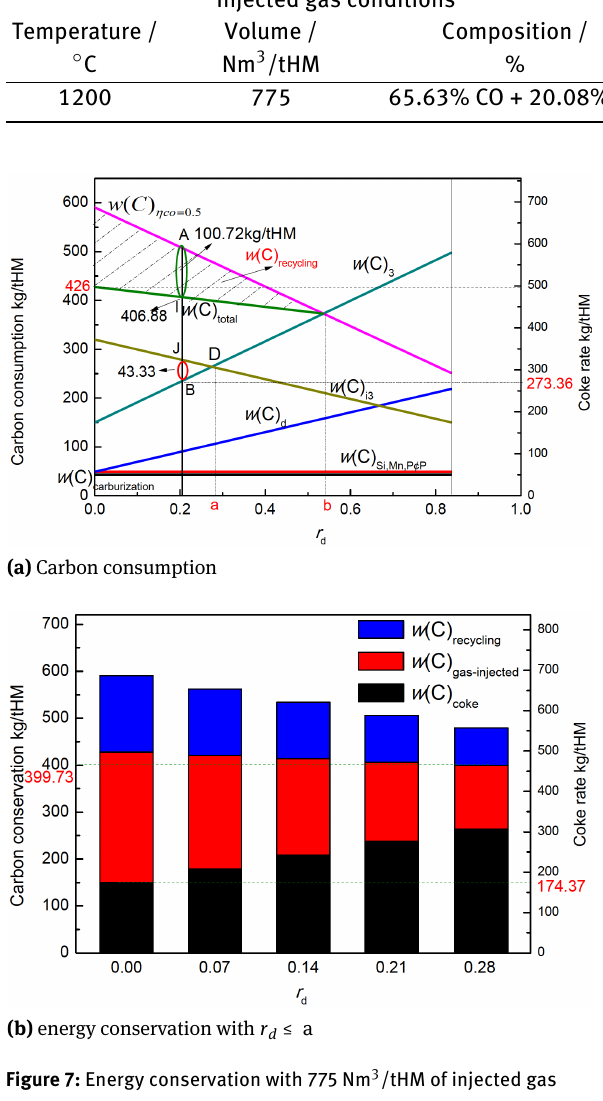
Figure 7: Energy conservation with 775 Nm 3 /tHM of injected